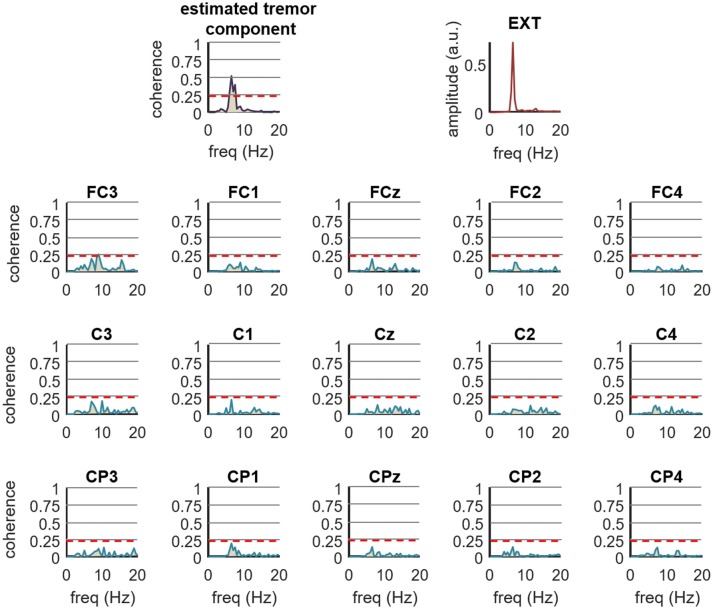
Comparison of the proposed method for the detection of tremor-related cortical activity (F = 8) with the traditional coherence approach in experimental recordings. The top right plot shows the spectrum of the smoothed CST form right wrist extensor of an ET patient performing the postural task (EXT). The top left plot shows the coherence between the CST and the tremor EEG component as estimated by the proposed method, while the remaining 12 plots show the coherence between the Laplacian filtered EEG signals and the CST. The label on top of each plot indicates the central EEG electrode. Red dashed lines represent the 99% confidence limit. Note the increase in coherence yielded by our method compared to the traditional coherence approach. Coherence calculated by traditional approach was not significant in any of the electrodes.